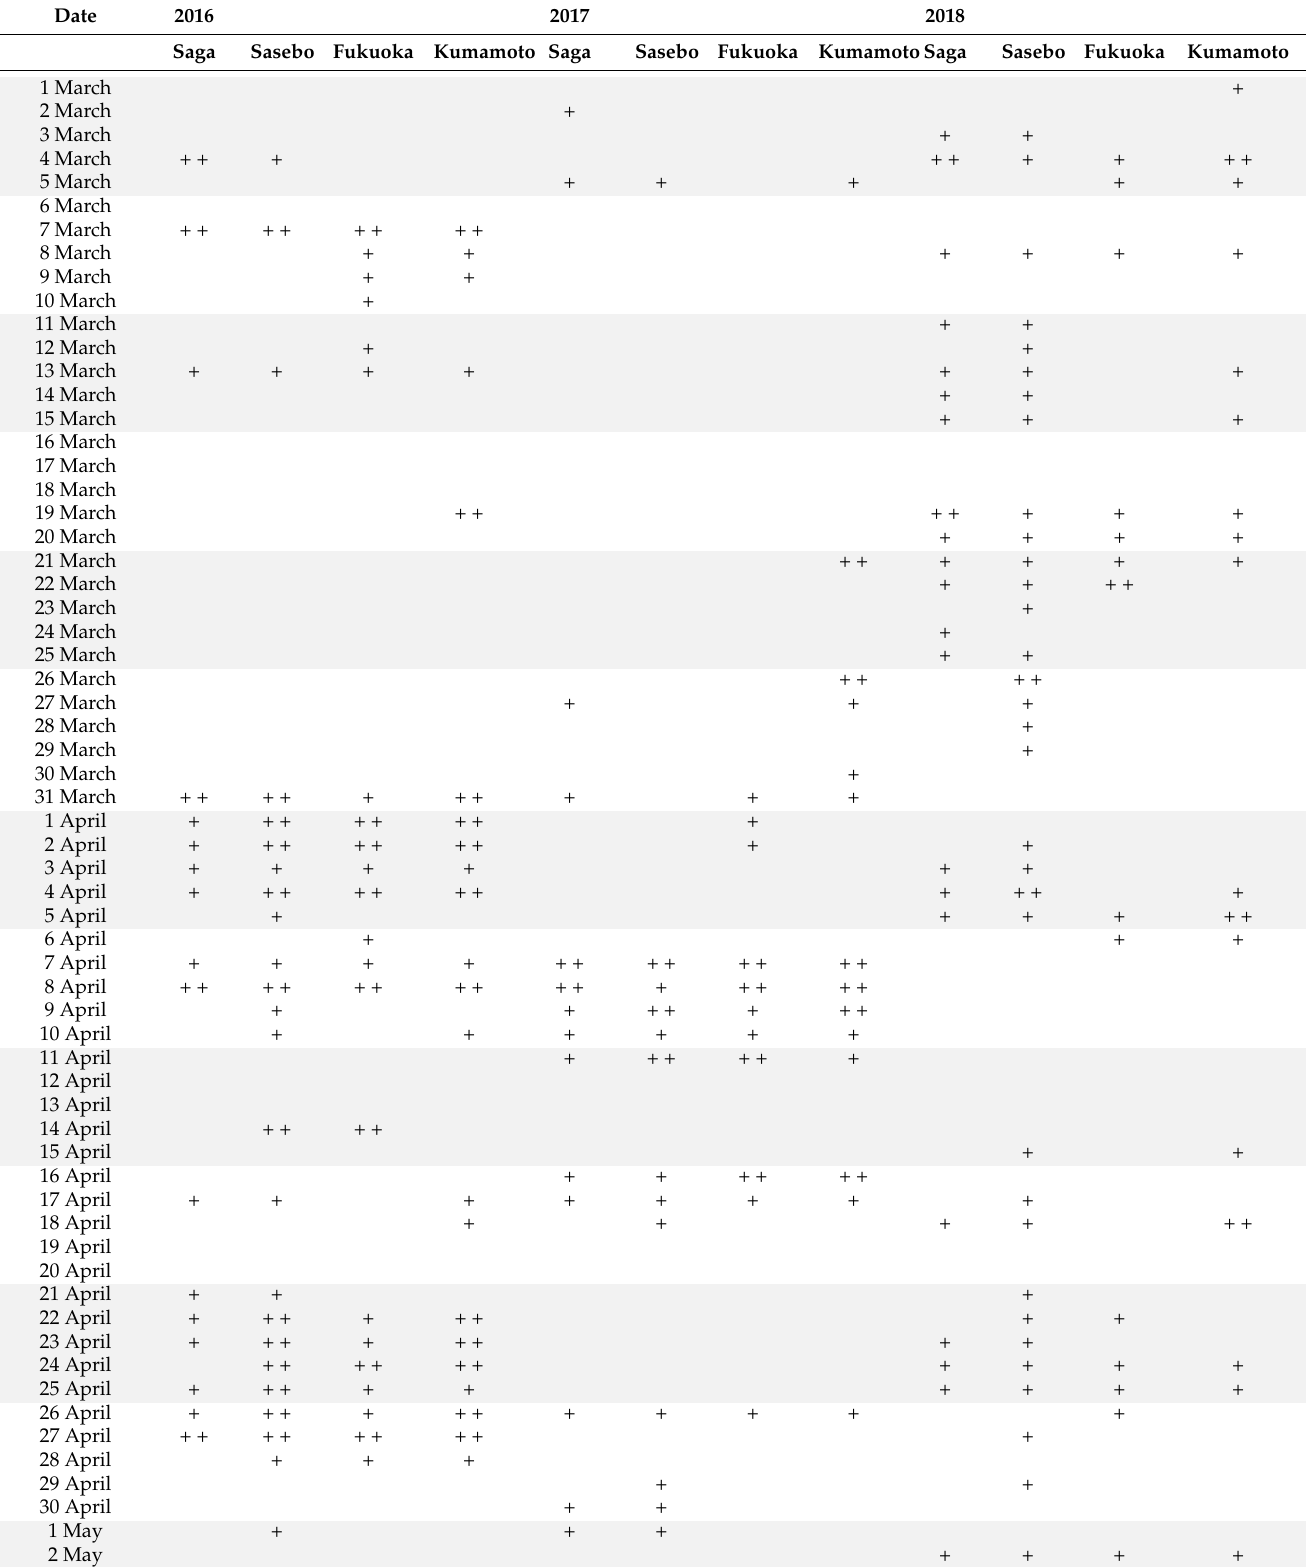
Table 3. Occurrence of favourable meteorological conditions (+ +) and marginal meteorological con- ditions (+ +) for infection of onion downy mildew output as assessed using the infection risk model a